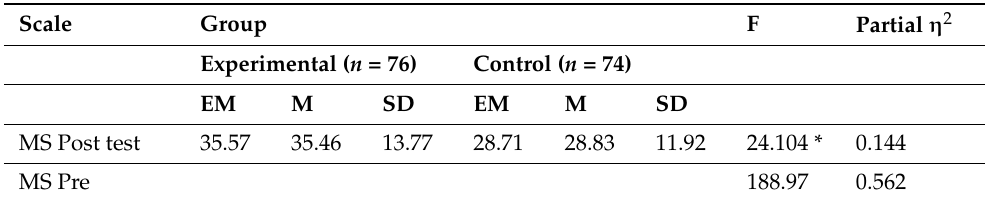
Table 3. ANCOVA test for the Maturity